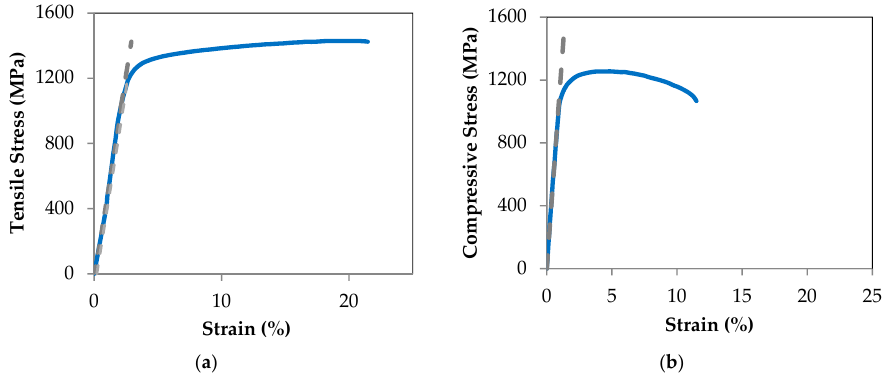
Figure 12. Tensile ( a ) and compressive ( b ) stress-strain plots for Ti-6Al-4V hardware. The tensile and compressive yield stresses by 0.2% offset strain technique are calculated to be 1186.8 MPa and 1098.6 MPa, respectively.